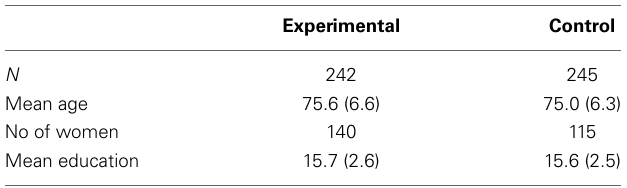
Table 1 | Demographic information of experimental and control